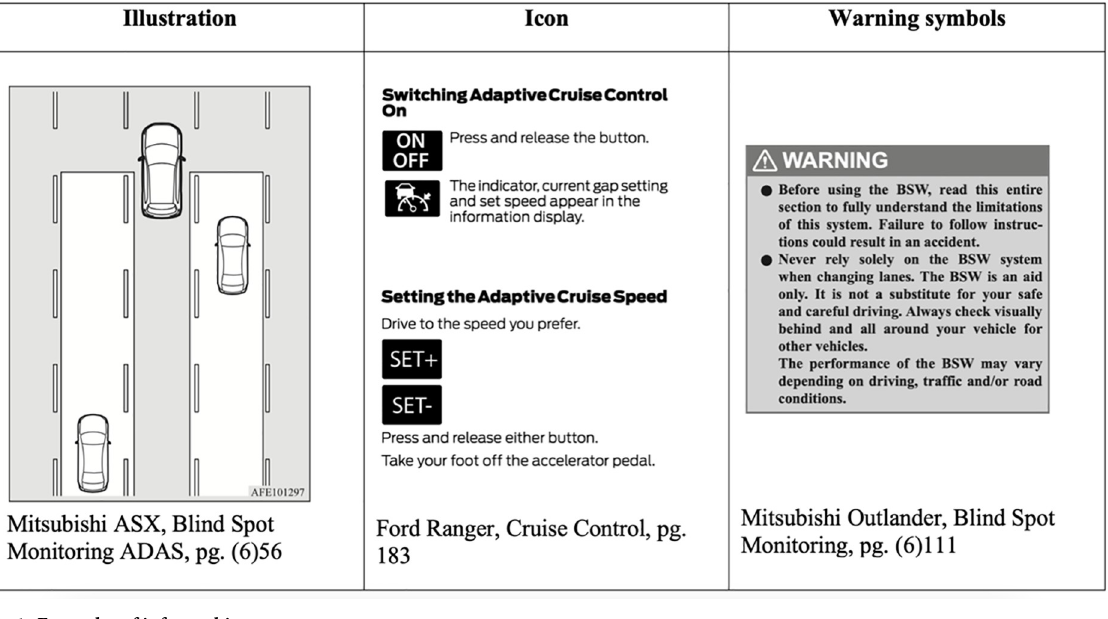
Fig 1. Examples of